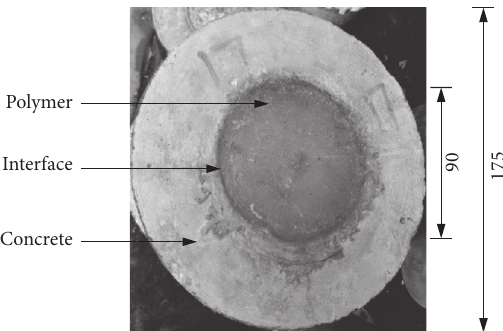
Figure 2: Details of bonding specimens (mm).